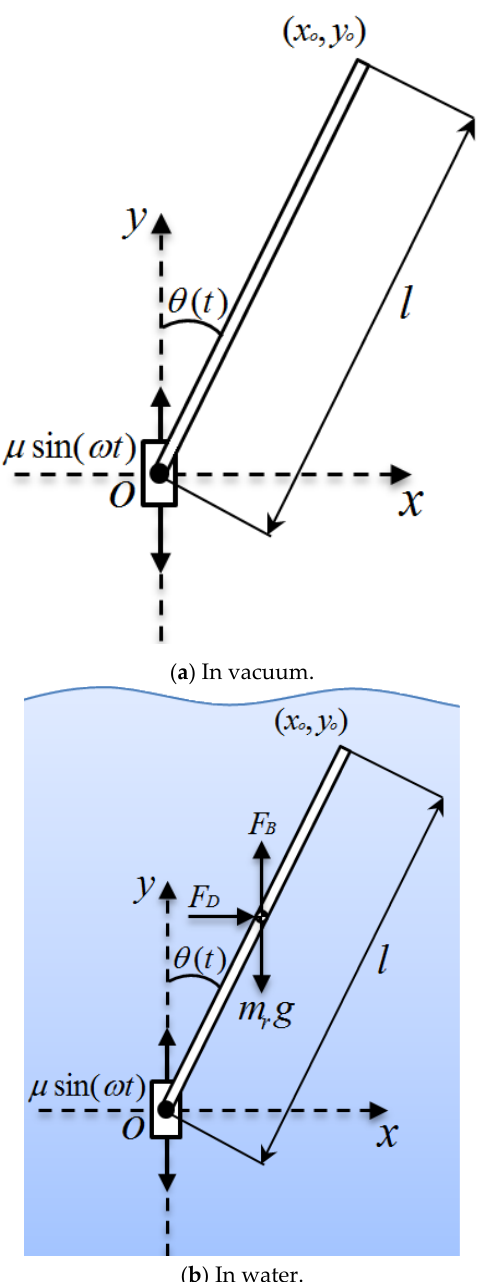
Figure 2. Inverted pendulum systems with oscillatory input sources ( a ) in vacuum and ( b ) in water.